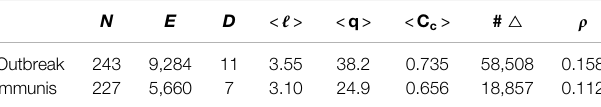
TABLE 1 | For the outbreak and immunisation period networks: the number of nodes N , edges E , and triangles # △ ; the graph diameter D and density ρ ;